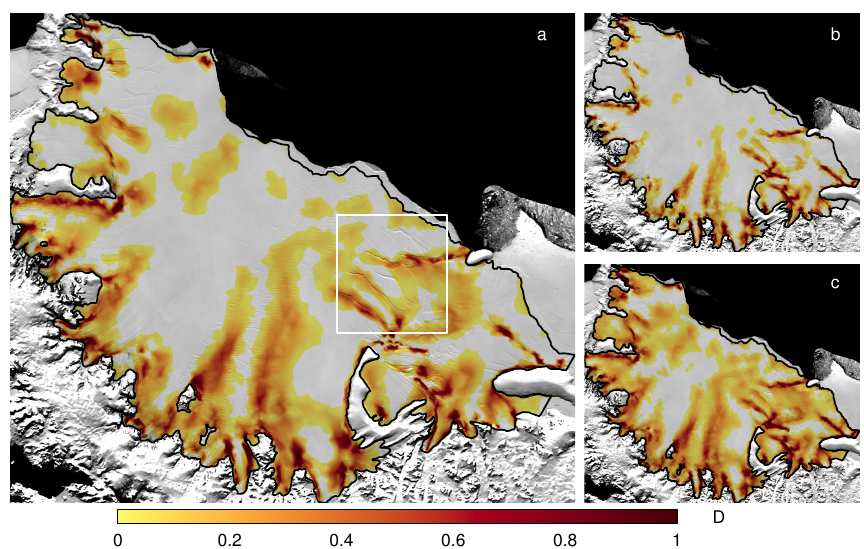
Fig. 4. (a) Damage from Eq. (17). White box indicates area of Fig. 7; (b) damage calculation using the same inverted ice rigidity ( B i − ) but for a depth-integrated ice temperature assumed uniformly warmer by 3 ◦ C ( B(T + 3 ) in Eq. (17) and (c) colder by 3 ◦ C. All panels plotted over 2009 MOA image.